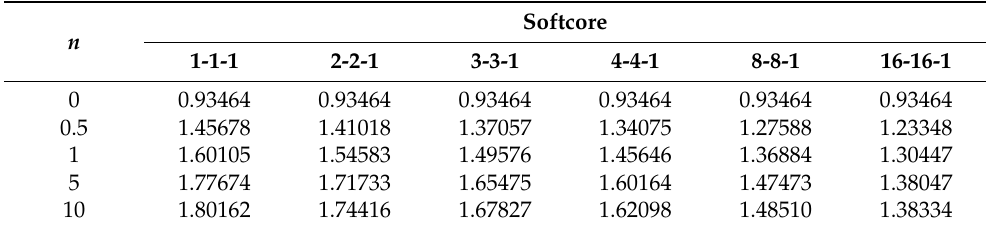
Table 5. The facesheet limits of the calibrated fundamental frequencies, ω , for simply supported square FG sandwich plates with homogeneous softcores ( b / h = 10 ).